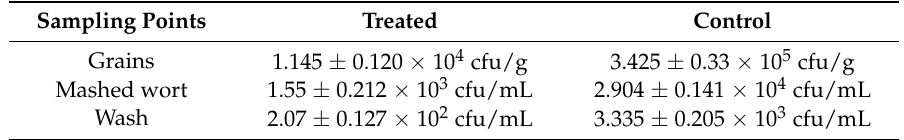
Table 1. Microbial of load samples after treatment (Mean ± S.D × CFU/mL (g)).